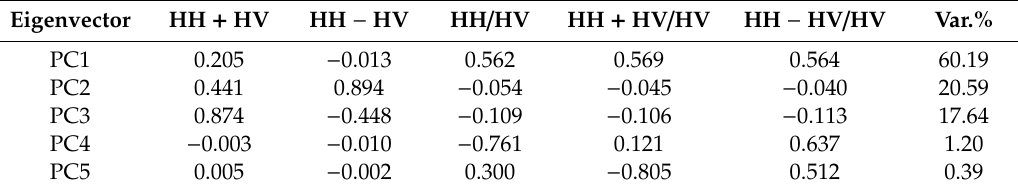
Table 4. Eigenvector loadings of PCA for PALSAR band math images.